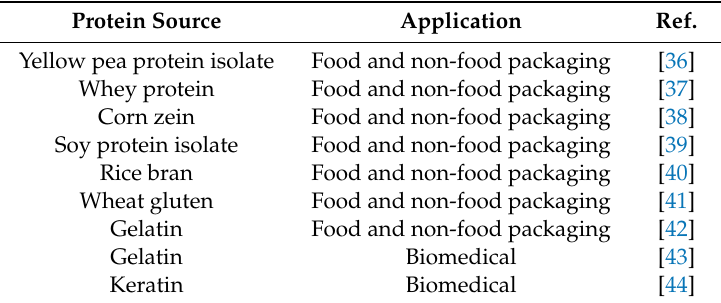
Table 1. Potential applications of some protein-based